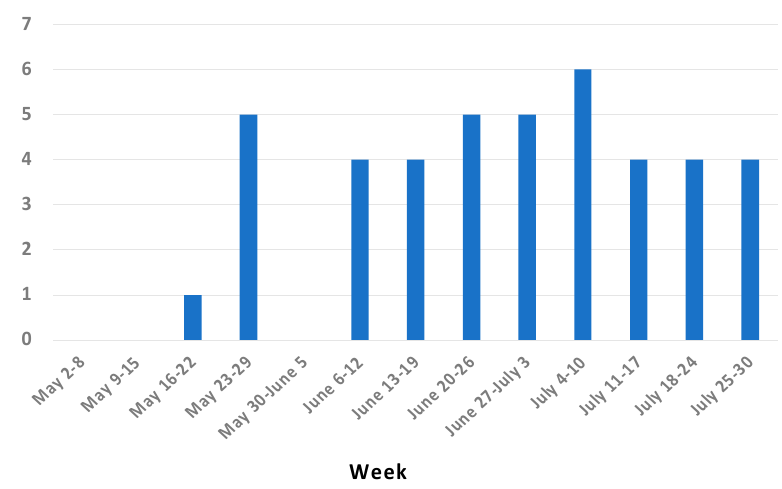
Figure 1. Temporal evolution of PCR–confirmed monkeypox cases.